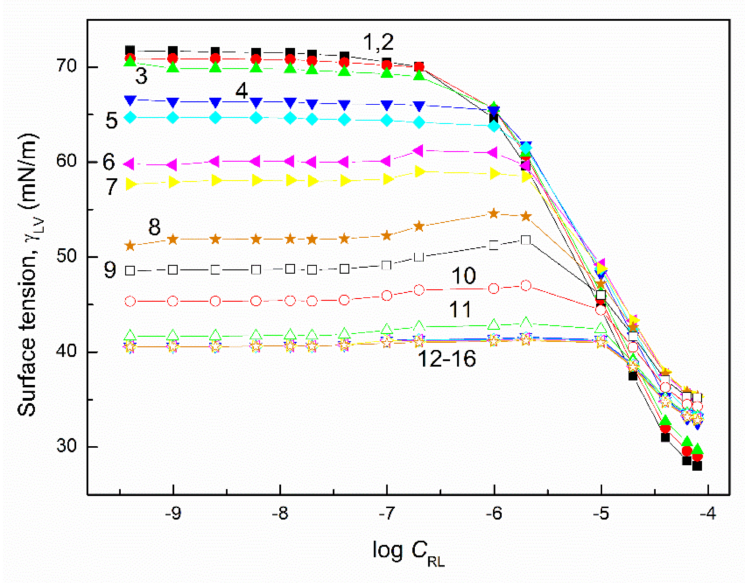
Figure 3. A plot of the surface tension ( γ LV ) of the aqueous solution of the RL and TX165 mixture vs. the logarithm of the RL concentration ( C RL ). Curves 1 − 16 correspond to the constant TX165 concentration equal to 1 × 10 − 8 , 5 × 10 − 8 , 1 × 10 − 7 , 5 × 10 − 7 , 1 × 10 − 6 , 5 × 10 − 6 , 1 × 10 − 5 , 5 × 10 − 5 , 1 × 10 − 4 , 2 × 10 − 4 , 4 × 10 − 4 , 6 × 10 − 4 , 8 × 10 − 4 , 0.001, 0.002, and 0.004 mole/dm 3 ,